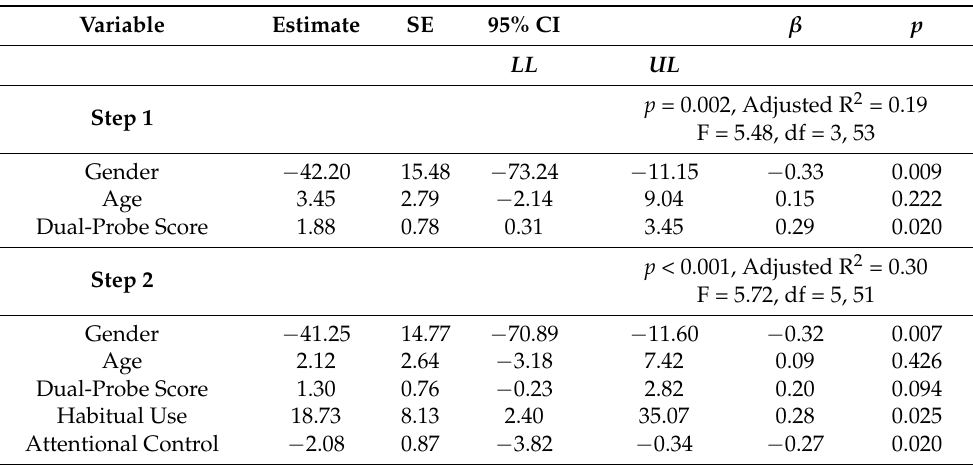
Table 4. Gender, age, dual-probe score, habitual use, and attentional control regressed on beer consumption.